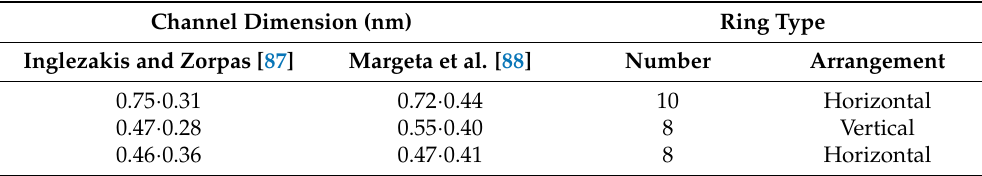
Table 5. Channel dimensions and ring types of natural zeolites.